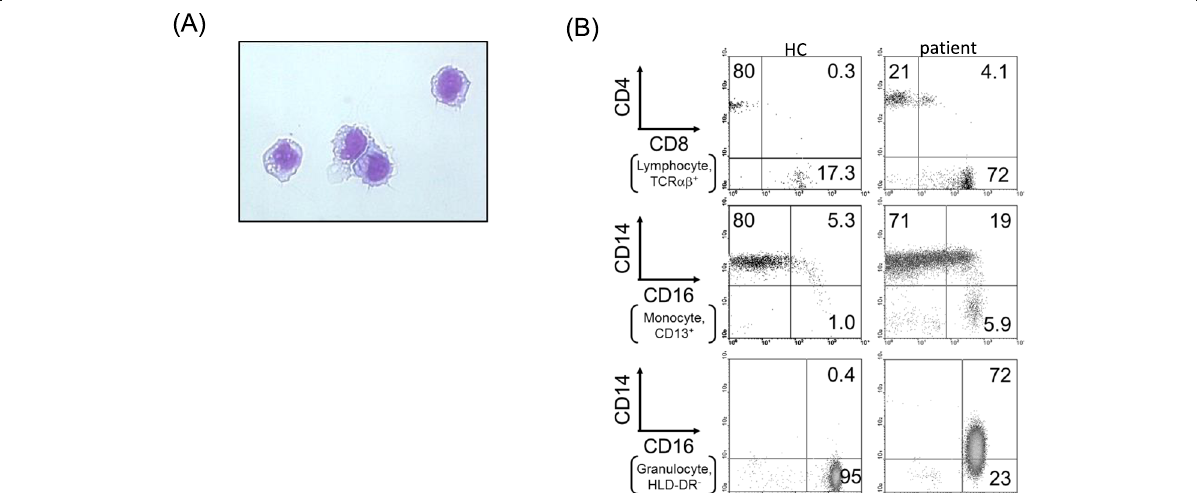
Fig. 3 Morphology and phenotypic profiles of blood of the patient. A Patient monocytes were sorted by flowcytometry and were Giemsa stained. No abnormalities were found. B Flow cytometric analyses of the blood from healthy donor (HC) and the patient. Top panels show the CD4 and CD8 expression profiles of lymphocyte-gated TCR αβ + cells. CD4+CD8+TCR αβ + lymphocyte percentage was higher in the patient than in the HC. Middle panels show the CD14 and CD16 expression profiles in the CD13+ cells (monocyte-gated). CD14+CD16+ monocyte percentage was elevated in the patient compared to the HC. Bottom panels show the CD14 and CD16 expression profiles of HLA-DR-negative cells in the large cells defined by Forward and Side scatter plots (granulocyte-gated). CD14+CD16+ granulocyte percentage was augmented in the patient using the HC as